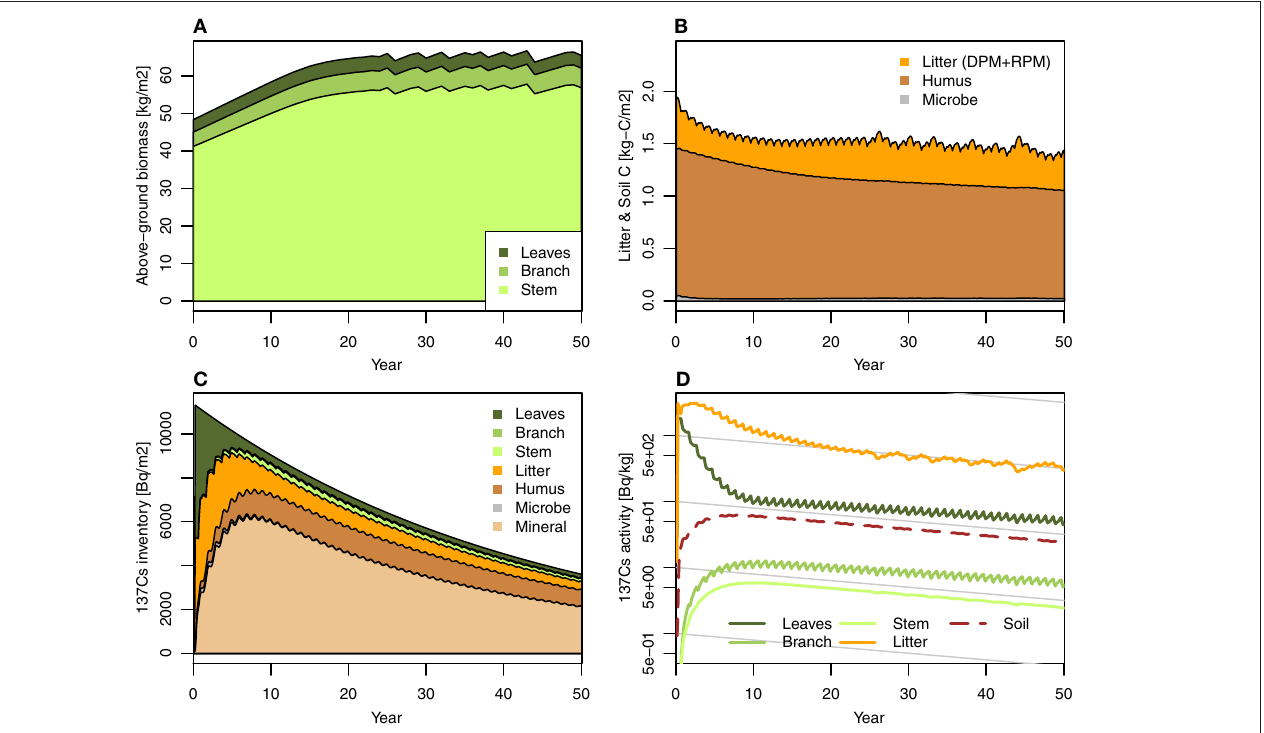
FIGURE 2 | Simulation case 1: No forest management. (A) Forest biomass (annual), (B) litter layer and soil C, (C) 137 Cs inventory, and (D) 137 Cs